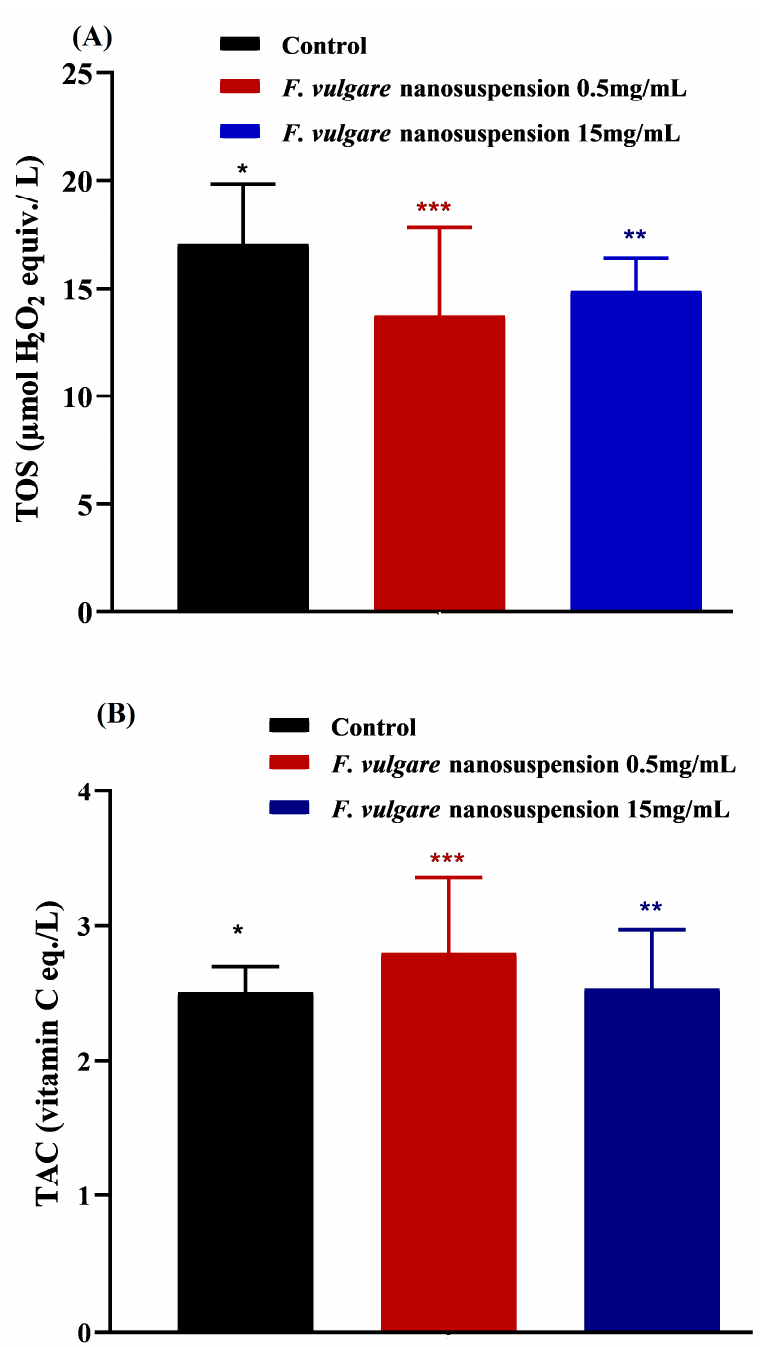
Figure 6. Effects of F. vulgare on ( A ) TOS and ( B ) TAC following sciatic nerve lesion. *, **, *** represents the significance of results/data.